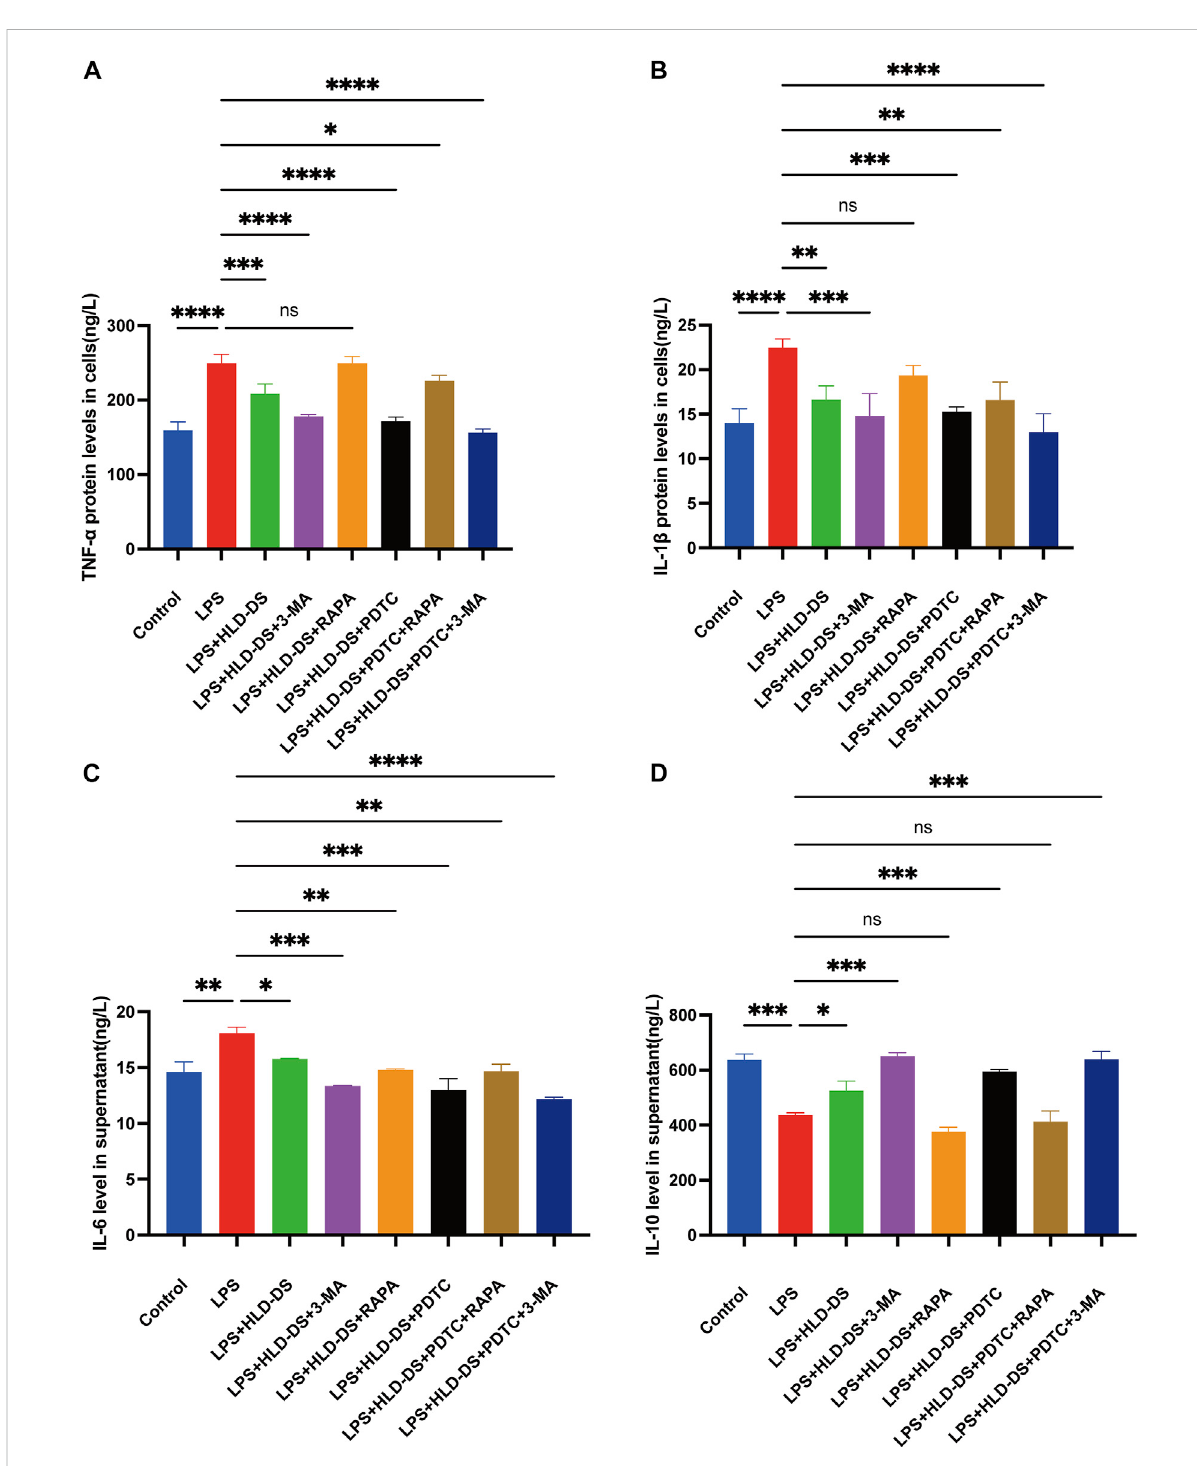
FIGURE 7 HLDalleviated LPS-inducedin fl ammationinNCM460 cellsbyinhibitingtheNF- κ Bpathway andautophagy. ( A – D )TNF- α , IL-6, IL-1 β , andIL-10 levels in the cell supernatant were detected by Elisa. All data are expressed as the mean ± SD. ( n = 3). * p < 0.05, ** p < 0.01, *** p < 0.001, **** p <